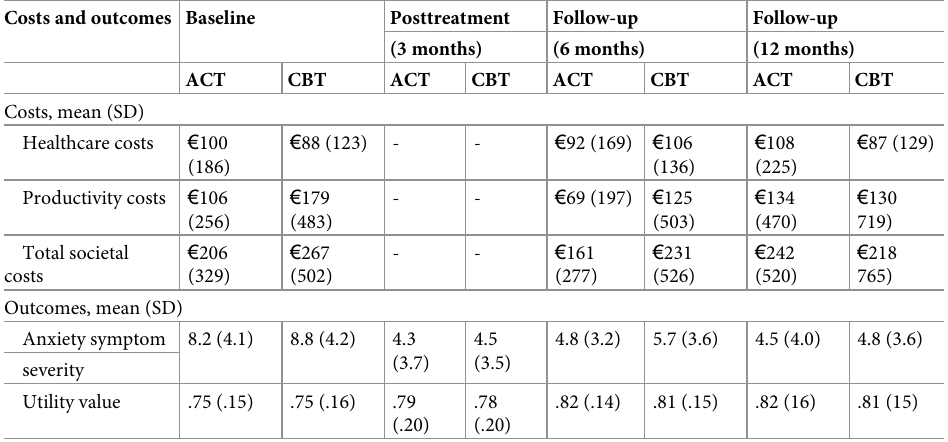
Table 2. Mean costs and outcomes by condition over